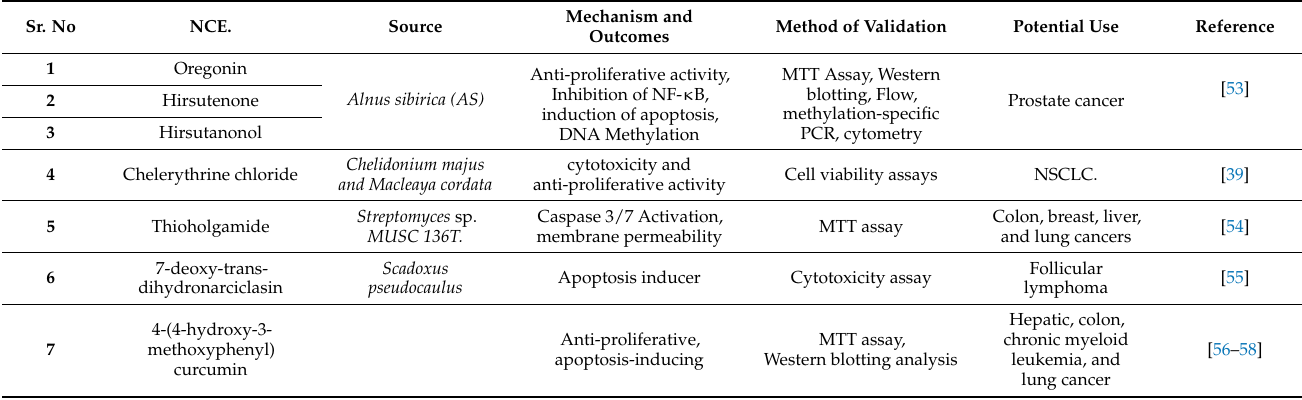
Table 2. Potential NCEs with therapeutic effects against